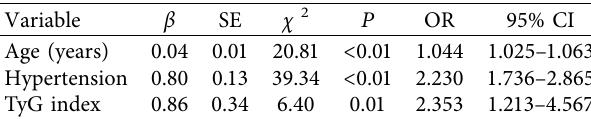
Table 2: Multiple logistic analysis for LAA